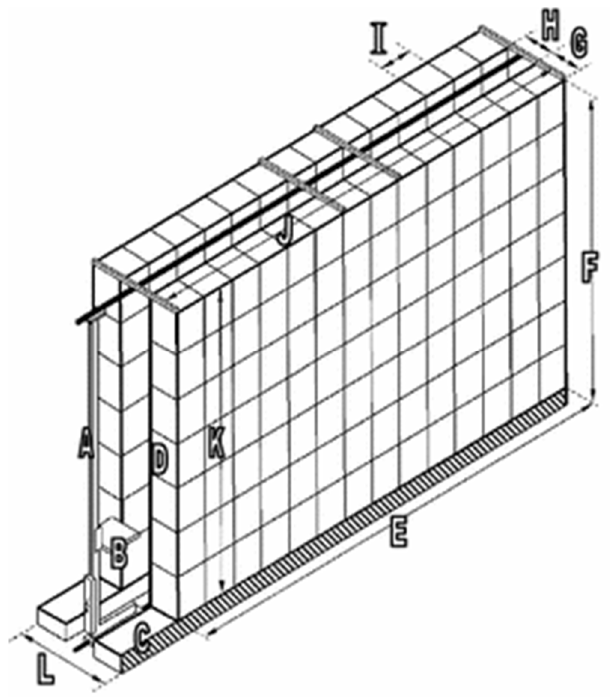
Figure 1. Typical AS/RS structure and its components